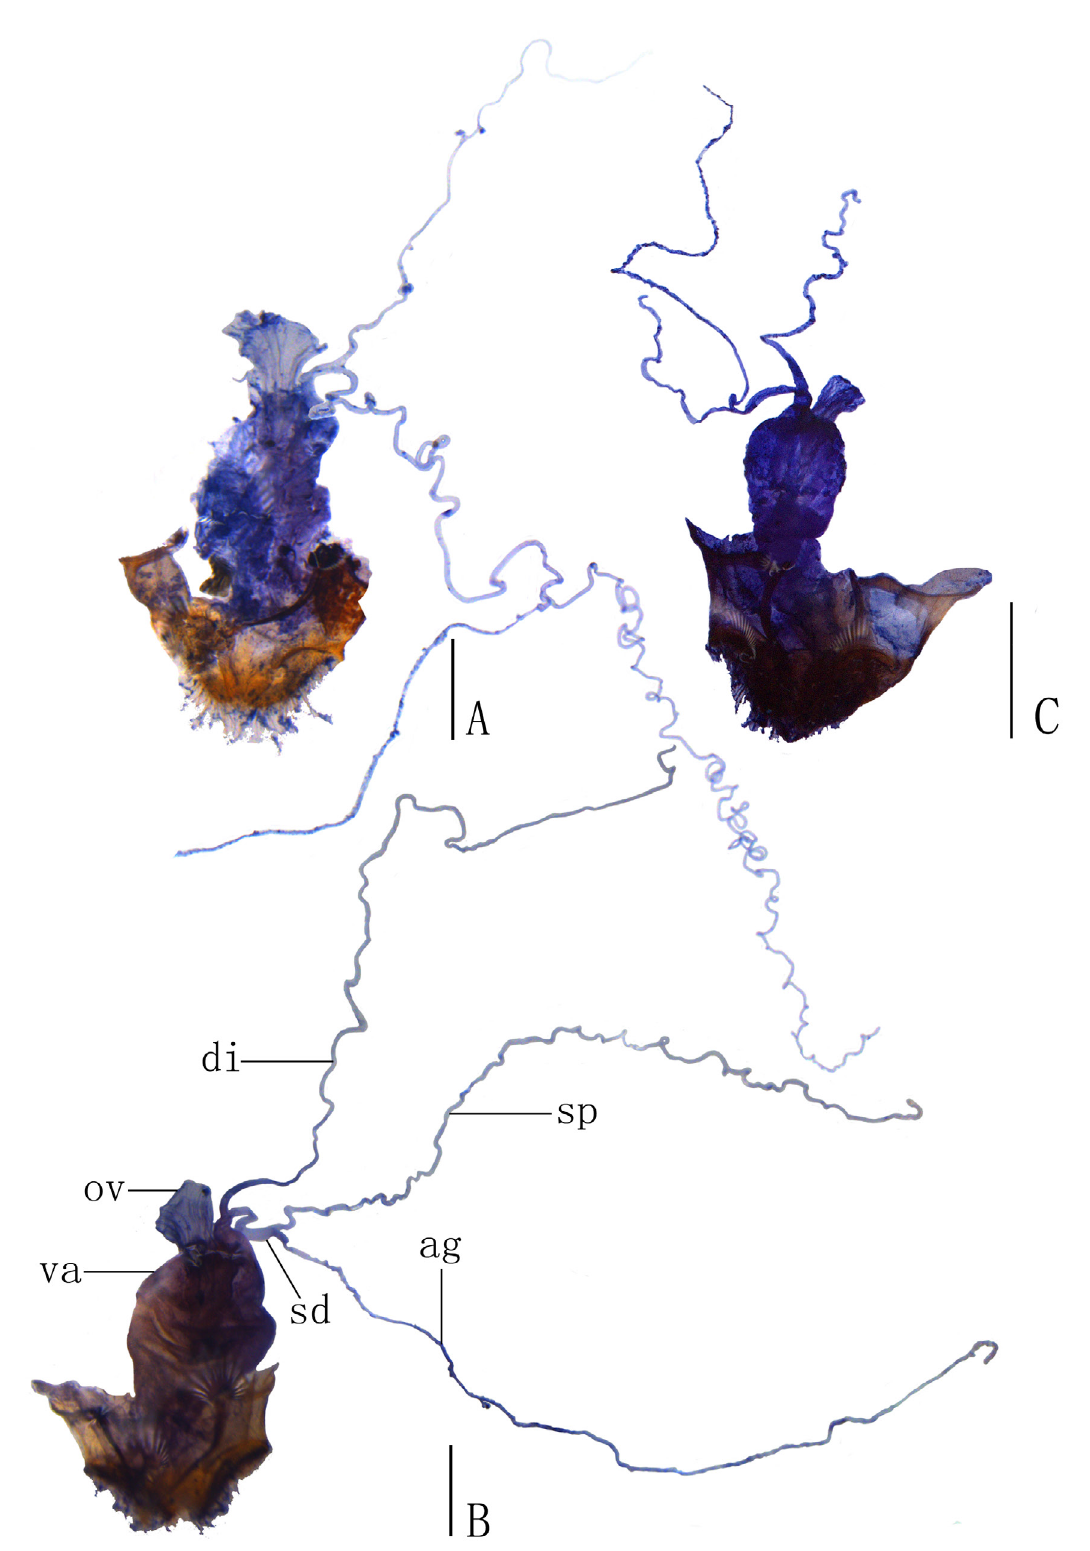
Fig. 7. Female internal reproductive system, lateral view. A . Stenothemus flavus Y. Yang & X. Yang sp. nov. (IZAS, IOZ(E)1659887). B . S. fukienensis Wittmer, 1974 (IZAS). C . S . chinensis (Wittmer, 1982) comb. nov. (MHBU). Scale bars: 0.5